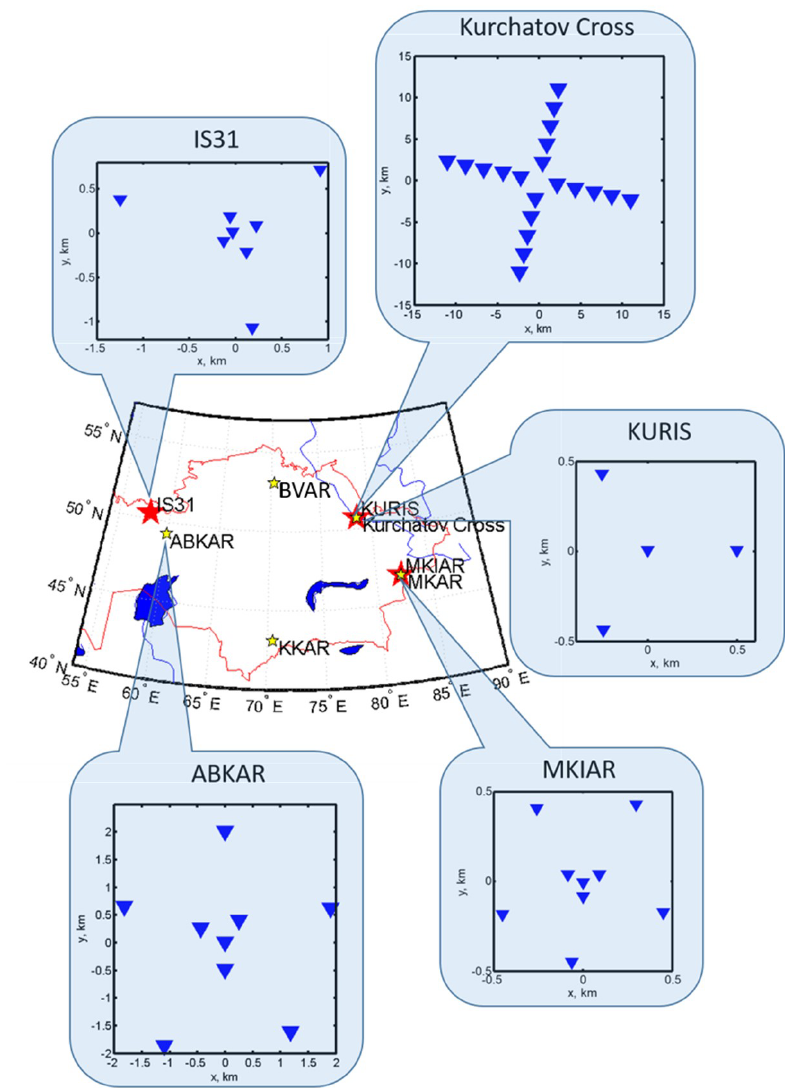
Figure 1. IGR monitoring network. Yellow and red stars are seismic and infrasound arrays, respectively. Seismic and infrasound arrays are collocated at Kurchatov (Kurchatov Cross/KURIS) and Makanchi (MKAR/MKIAR). IS31 infrasound and ABKAR seismic arrays are located ∼ 200km apart. The inset graphs show the array configurations. The configurations for KKAR and MKAR seismic arrays are not shown as they are similar to ABKAR’s